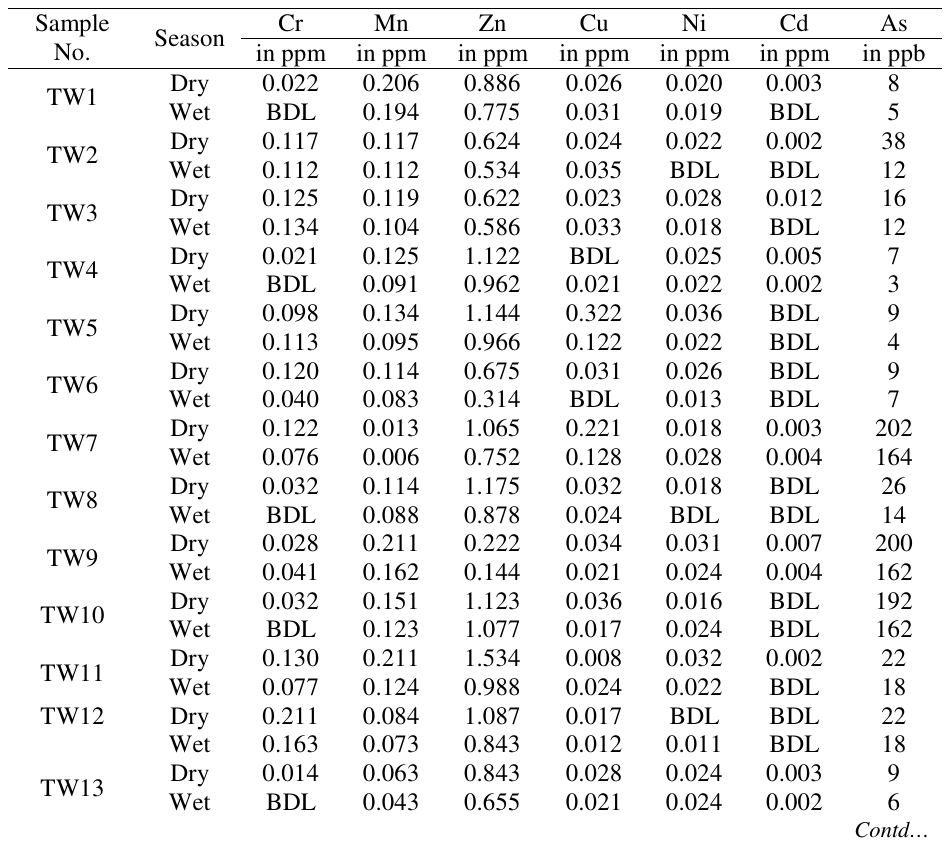
Table 2. Metal content in ground and surface water of Golaghat district at 20 different